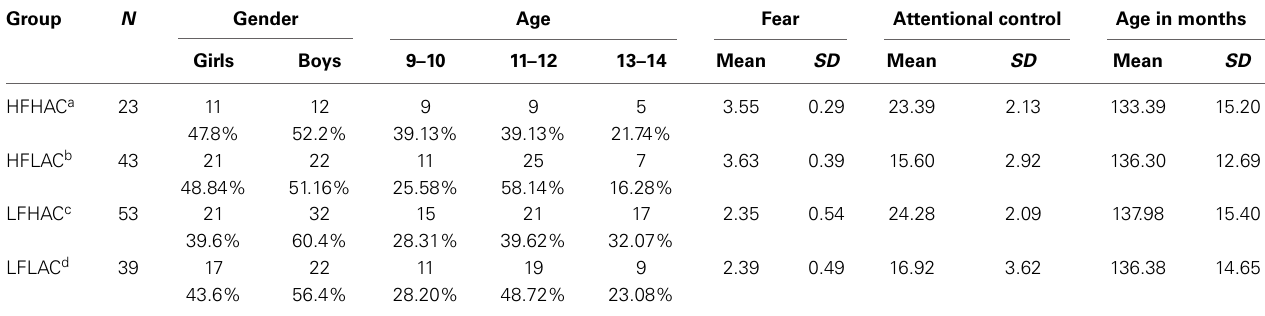
Table 1 | Descriptive data for each group as a function of both temperamental dimension (fear and attentional control), gender and age.